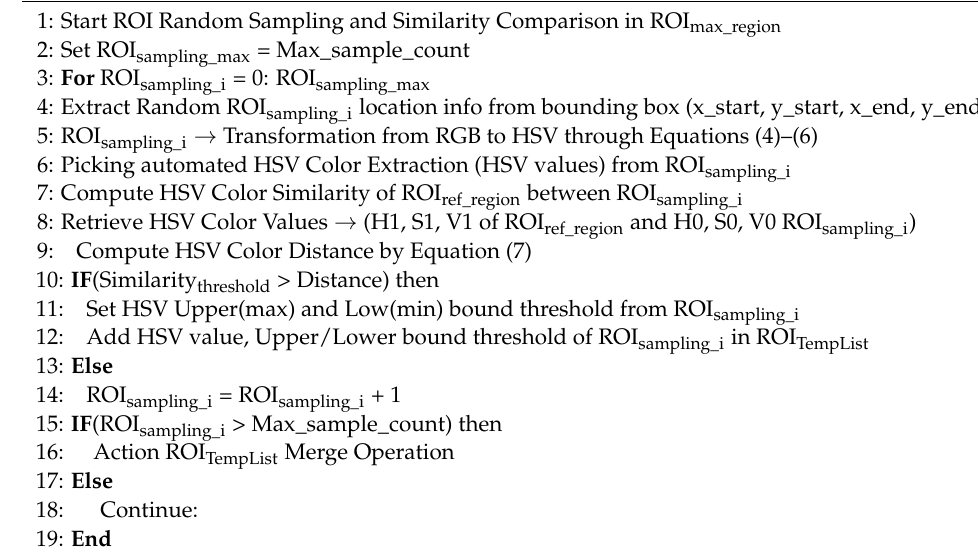
Algorithm 2. ROI Random Sampling and Similarity